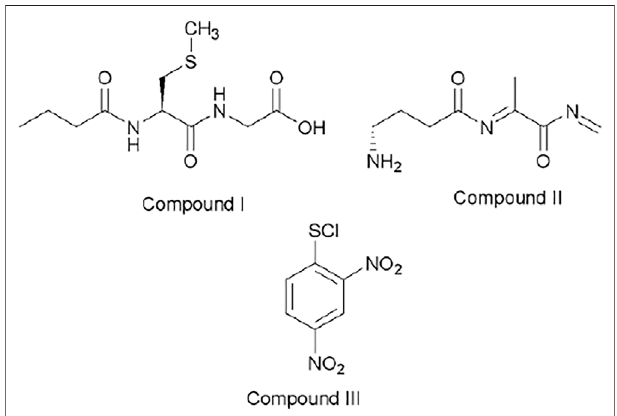
FIGURE 4 | Chemical structures associated with mass/charge ratio for the reaction between ClDNB and GSH and Me – GSH.